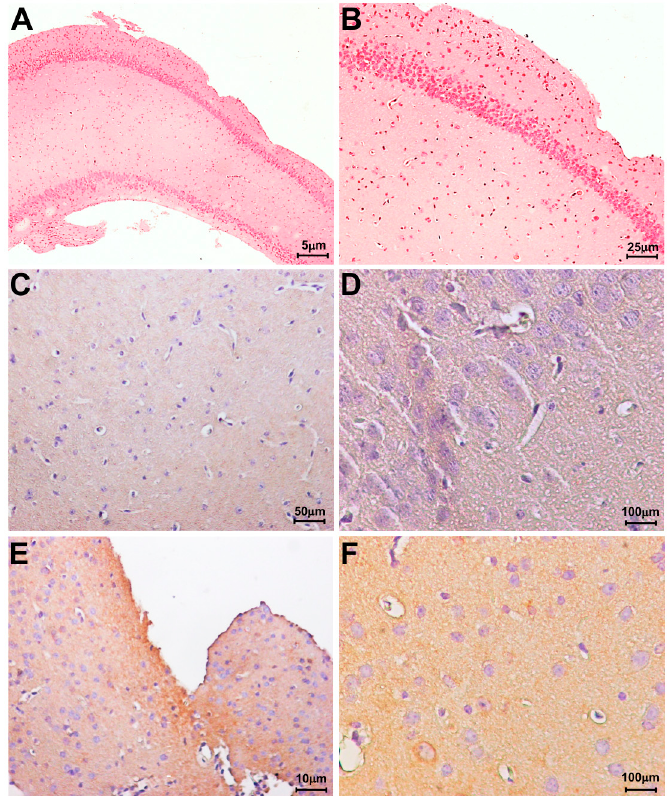
Figure 2. Immunohistochemical analysis of Lectin-like oxidized LDL receptor-1 (LOX-1) expression in hippocampal tissues. ( A , B ) haematoxylin eosin counterstain in hippocampal tissues from wild type mice; ( C – F ) immunohistochemistry for LOX-1; ( C , D ) A faint positive reaction for LOX-1 was observed